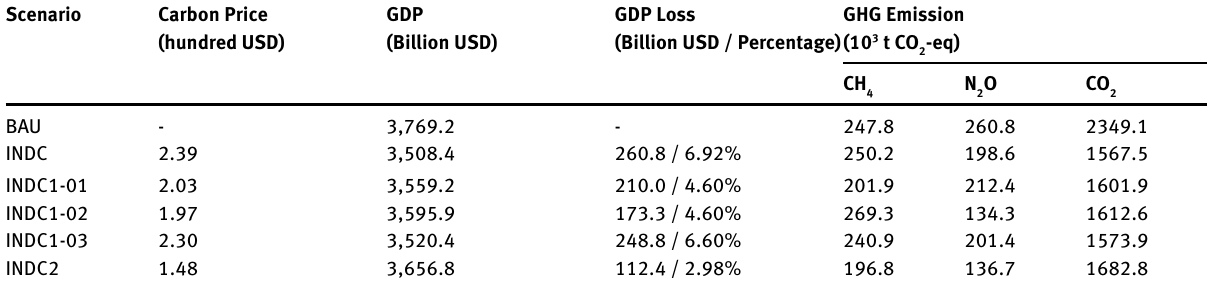
Table 3: Summary of CGE Simulation Result